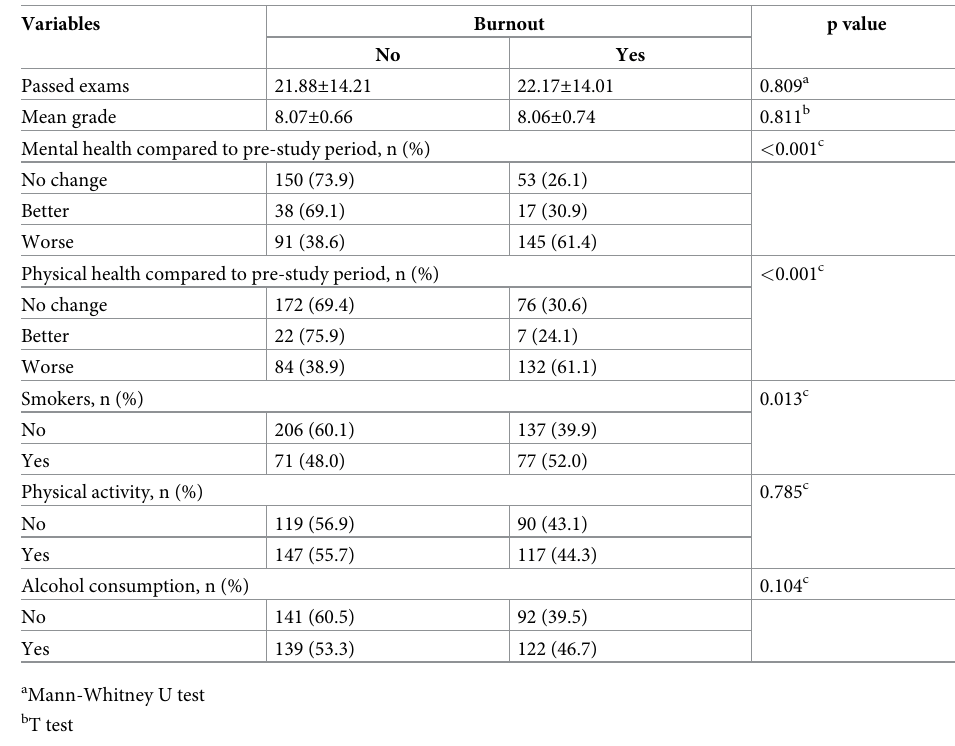
Table 2. Academic achievement, health behavior and self-assessed health status with regard to burnout among Belgrade veterinary